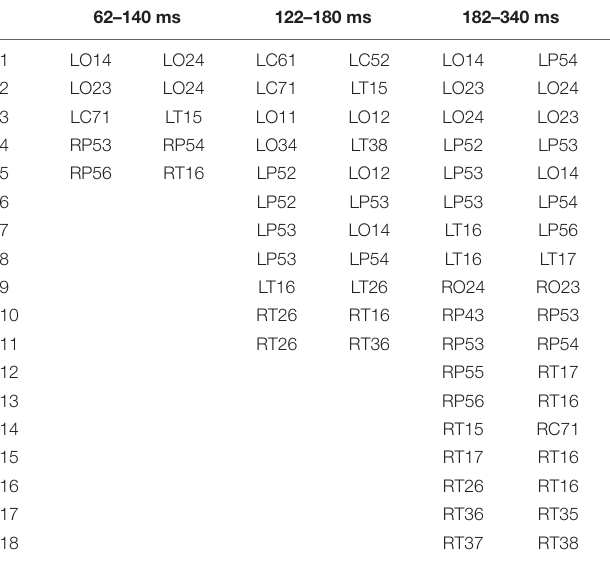
TABLE 4 | Time-dependent changes in significant functional connections during MGJs.